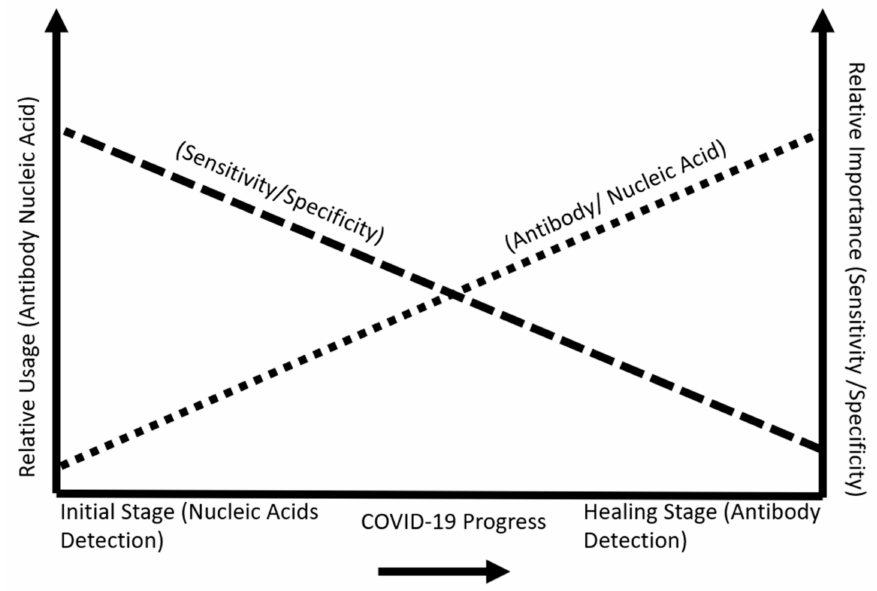
Figure 11. COVID-19 stage progression and importance of sensitivity and